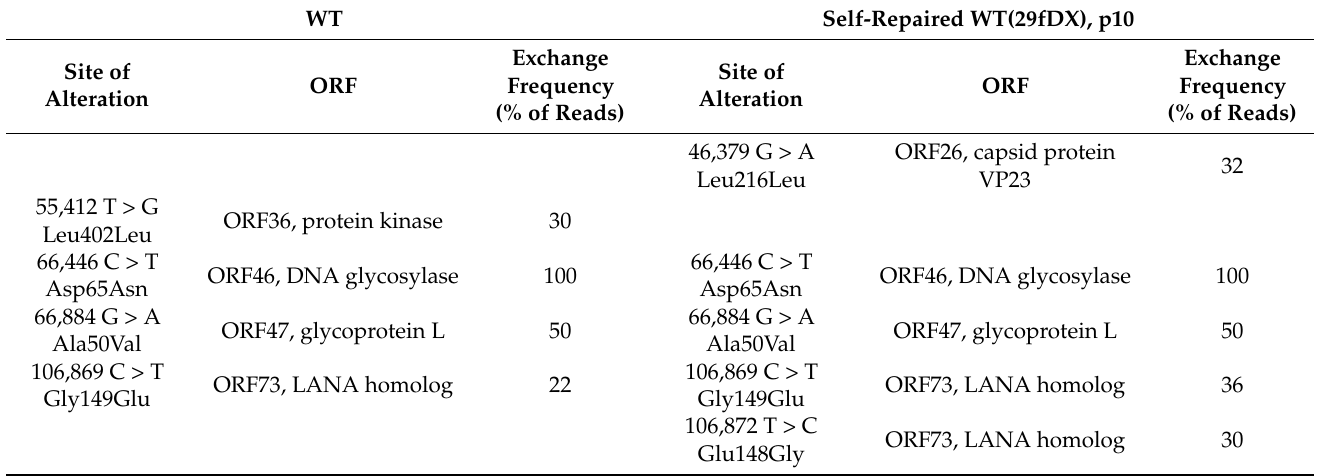
Table 1. Sequence alterations found by next-generation sequencing in coding regions of isolated virus